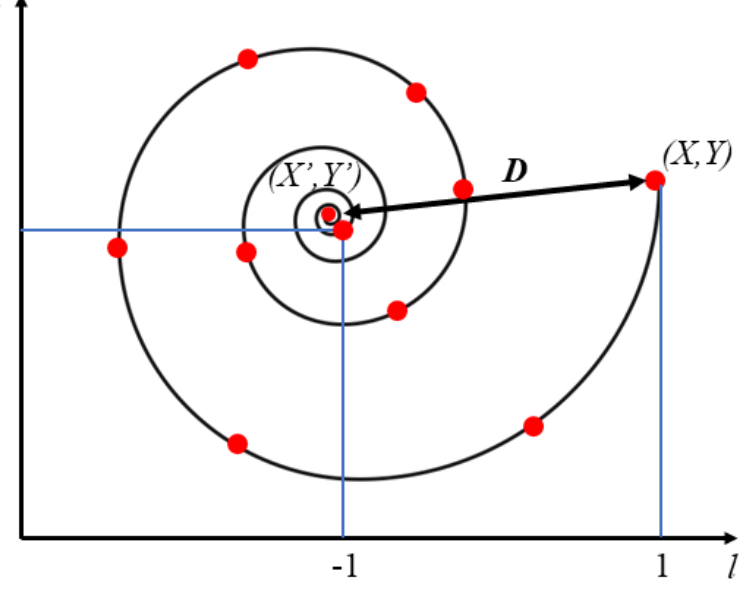
Figure 2. The model of the spiral updating